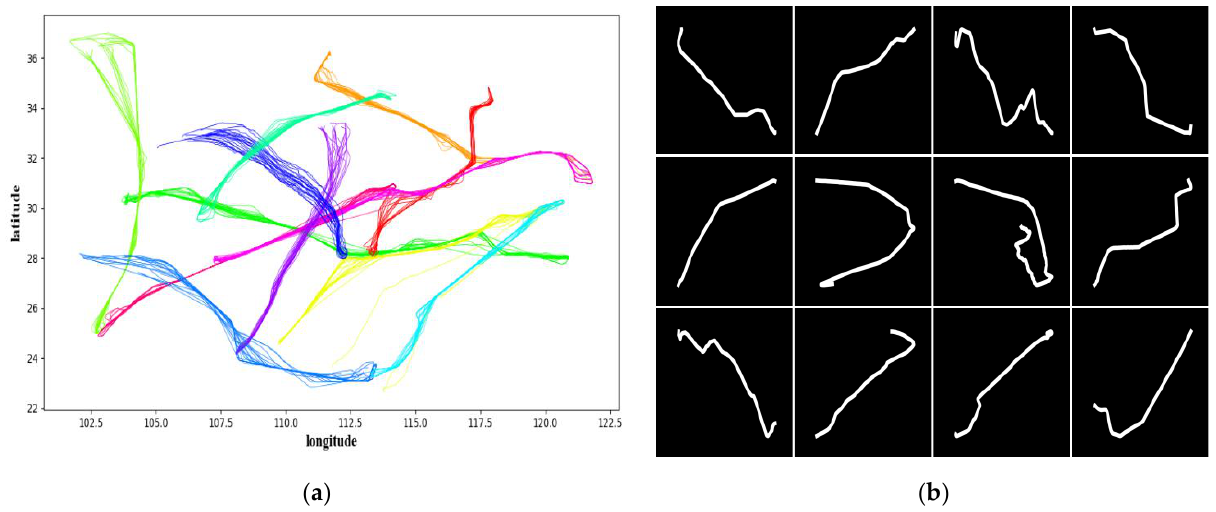
Figure 8. Simulation trajectory dataset. ( a ) Original trajectory image and ( b ) normalized trajectory